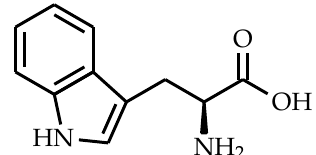
Figure 2. Chemical structure of L -tryptophan.